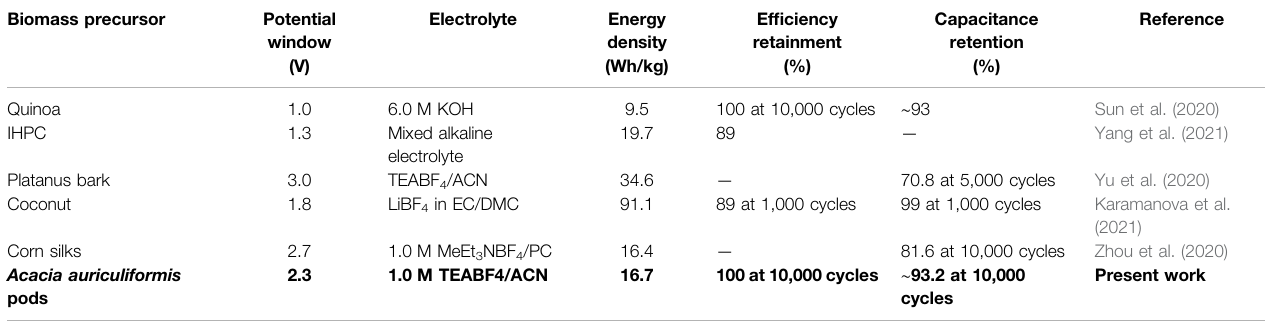
TABLE 3 | Comparison of the present work with some of earlier published research studies in the past 1 year. Biomass precursor Potential